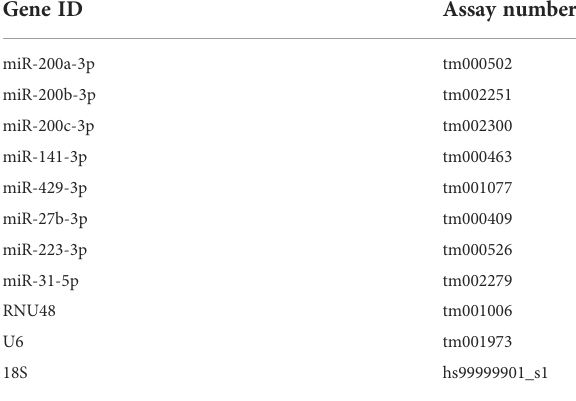
TABLE 2 TaqMan assays used in QPCR experiments. Note that due to high conservation, the miRNA assays are both applicable for rat and human